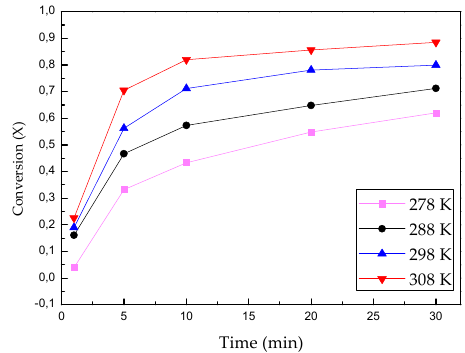
Figure 5. Effect of reaction time and temperature on the dissolution of the mineral.